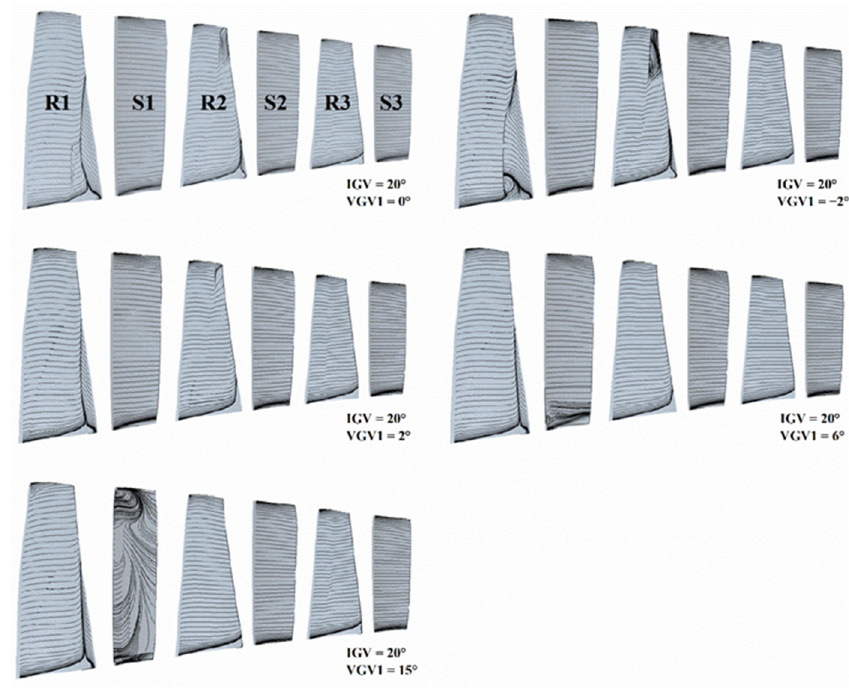
Figure 21. Limited streamlines on blade surfaces of first three stages (VGV1 adjustment).